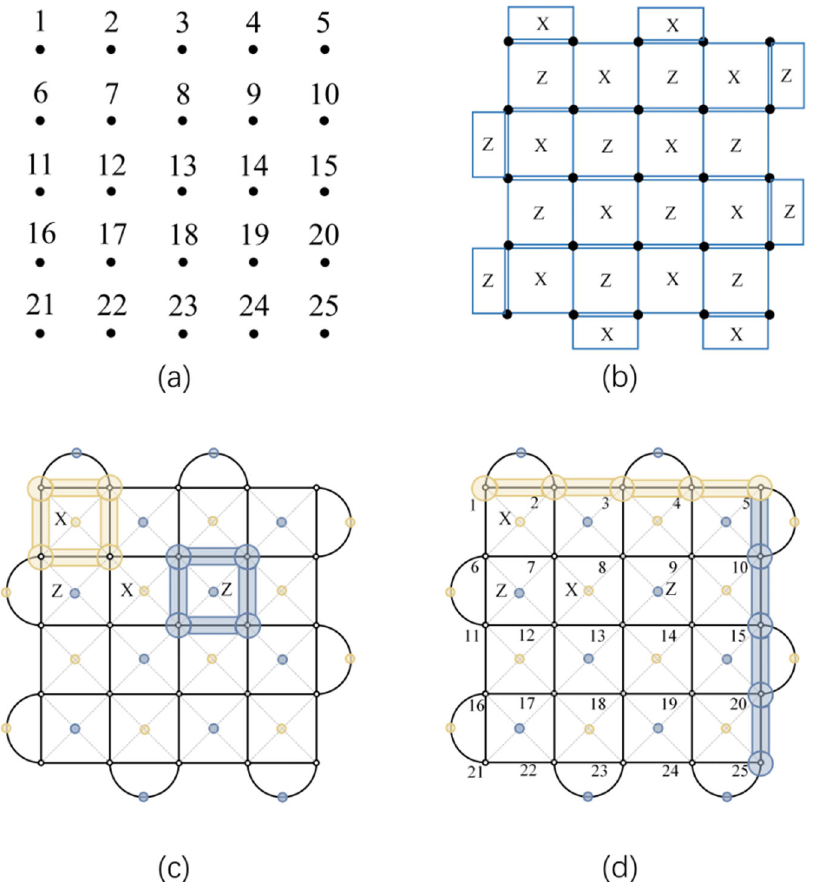
Fig. 2 Schematic diagram of a surface code with a code distance of 5. a The data qubit corresponds to the vertex of the lattice. b Qubits form two types of lattice operators: X and Z. c The four data quantum bits surrounding the X(Z) ancilla qubits form an X(Z) stabilizer. d The surface code has periodic boundaries, and the logical operators can also be on both sides of the